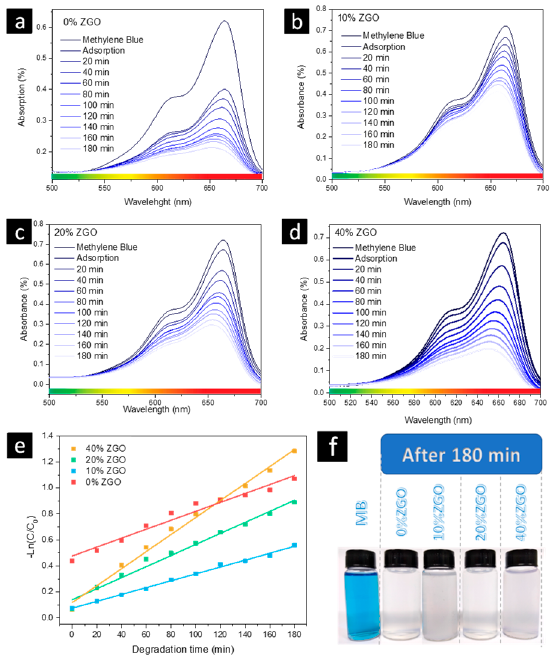
Figure 4. Photocatalytic activity of Zn 2 GeO 4 /g-C 3 N 4 nanocomposites. ( a – d ) Results of UV-vis absorption spectra of MB solutions containing Zn 2 GeO 4 /g-C 3 N 4 nanocomposites at various irradiation times, ( e ) first-order kinetics plots, and ( f ) digital photos of MB solutions after photocatalysis reaction.